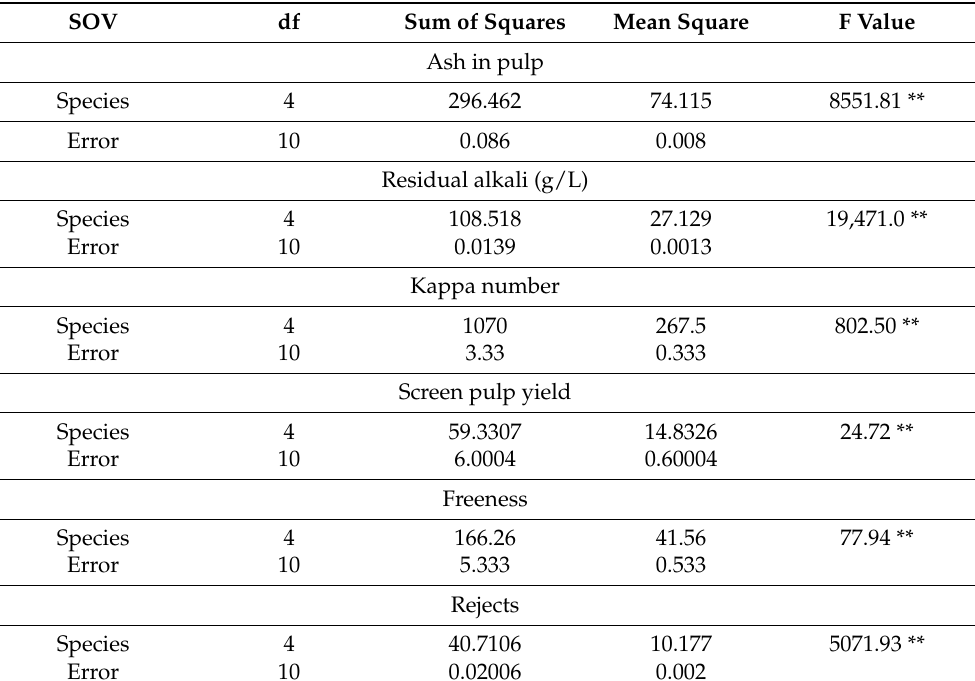
Table 3. ANOVA test for the chemical properties of the produced